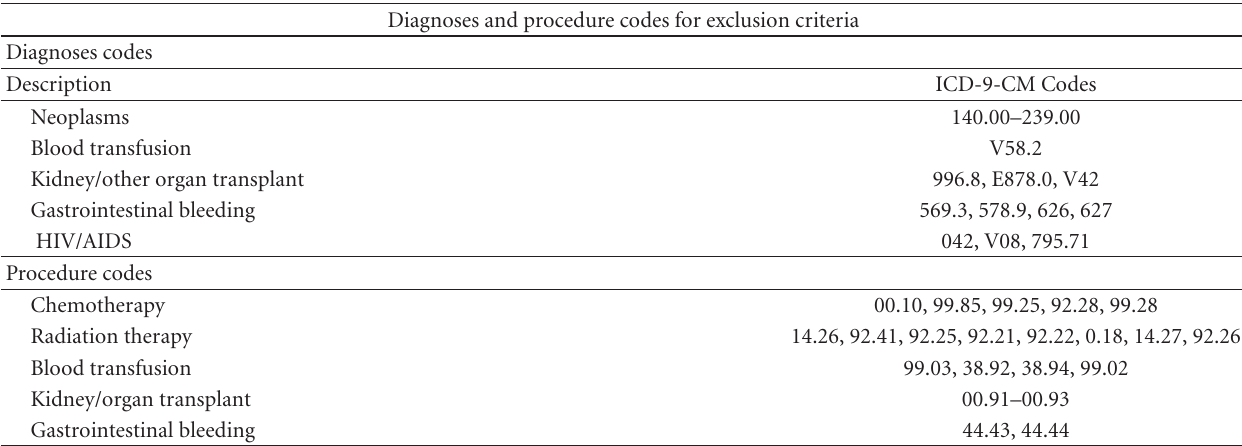
Table 2: Diagnoses codes (ICD-9-CM) and procedure codes used to identify Chronic Kidney Disease patients (exclusion criteria). Diagnoses and procedure codes for exclusion